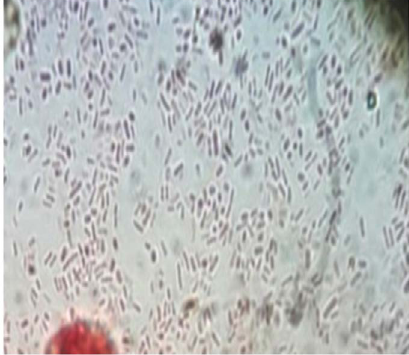
Fig. 2. Klebsiella stained with capsular stain.